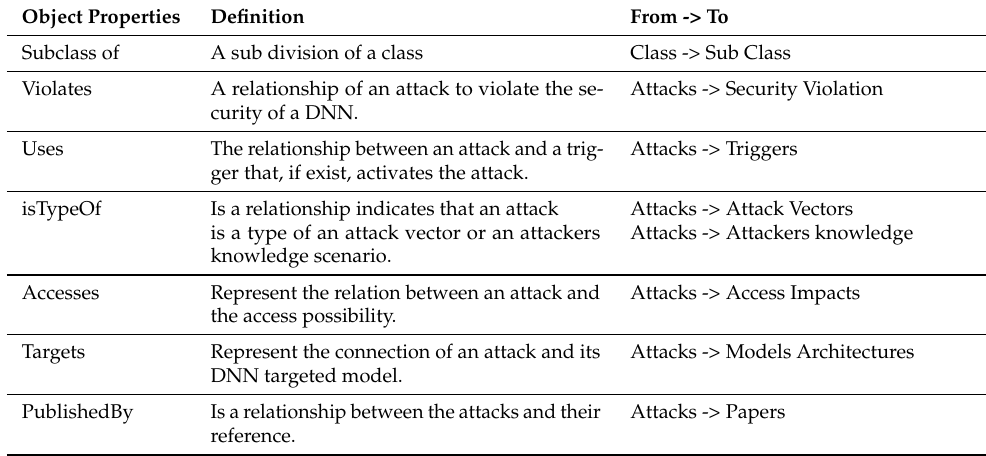
Table 10. Definition of the main relationships in DNNPAO.